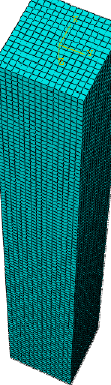
Figure 14. Mesh of the